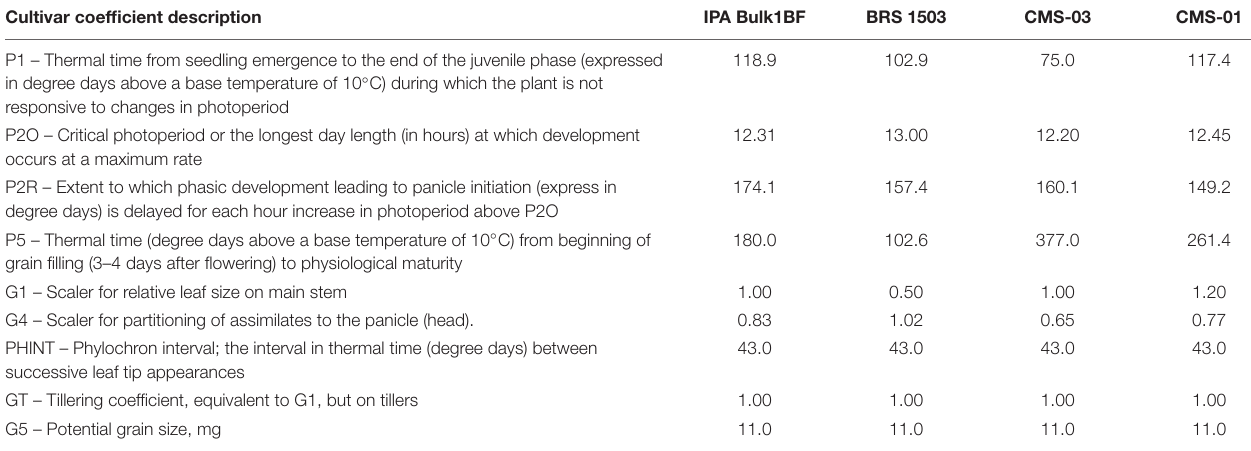
TABLE 2 | Genetic coefficients of pearl millet cultivars calibrated in DSSAT. Cultivar coefficient description